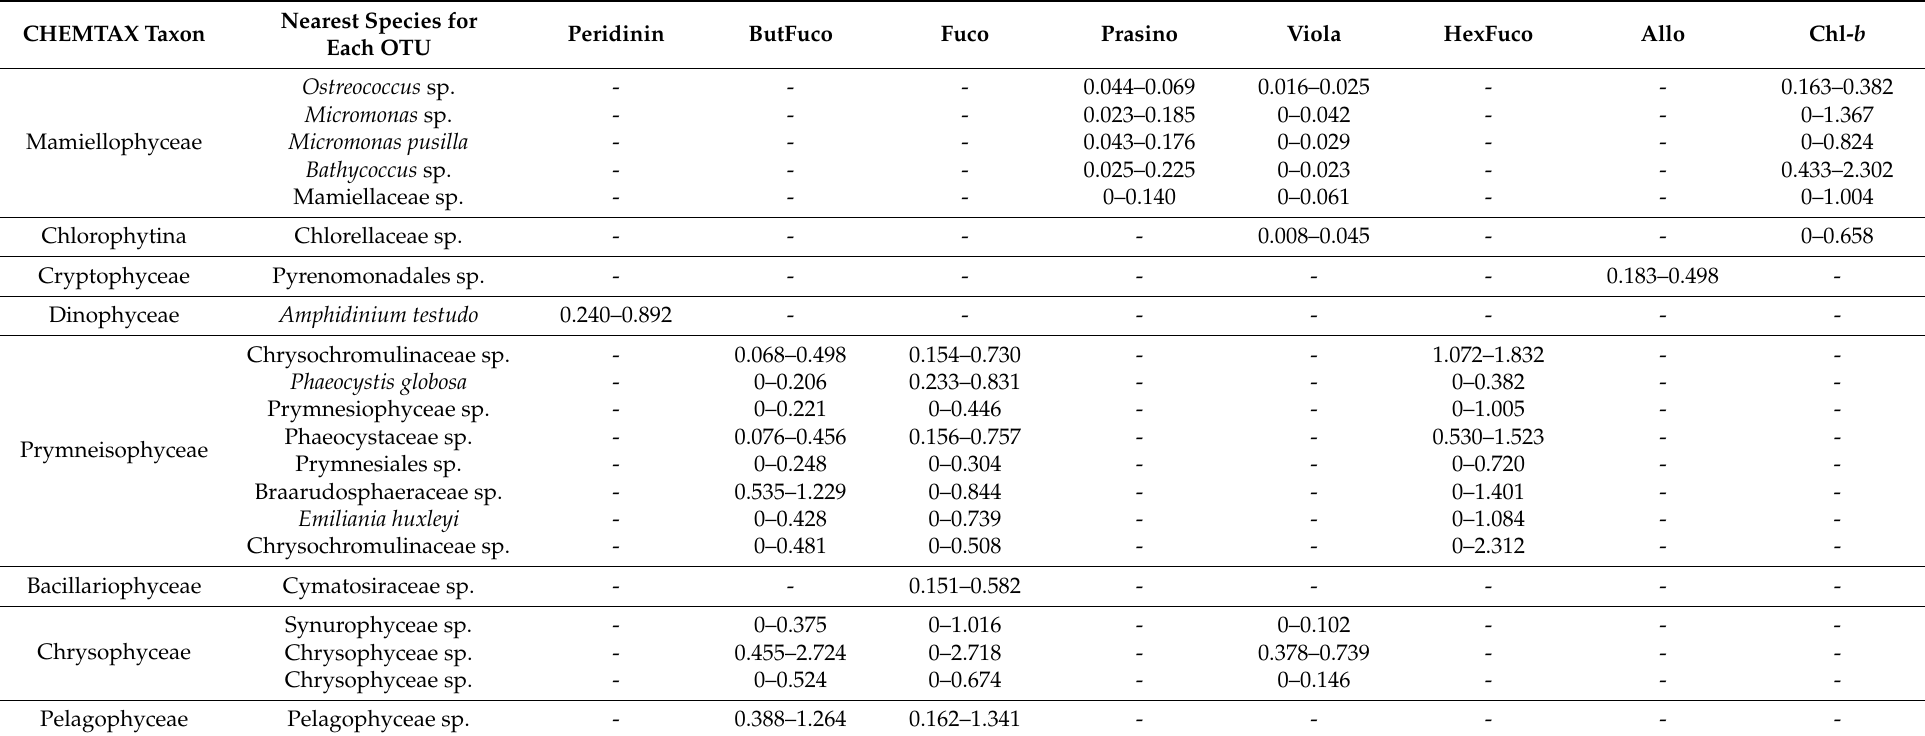
Table 5. NNLS-based 95% prediction intervals for pigment